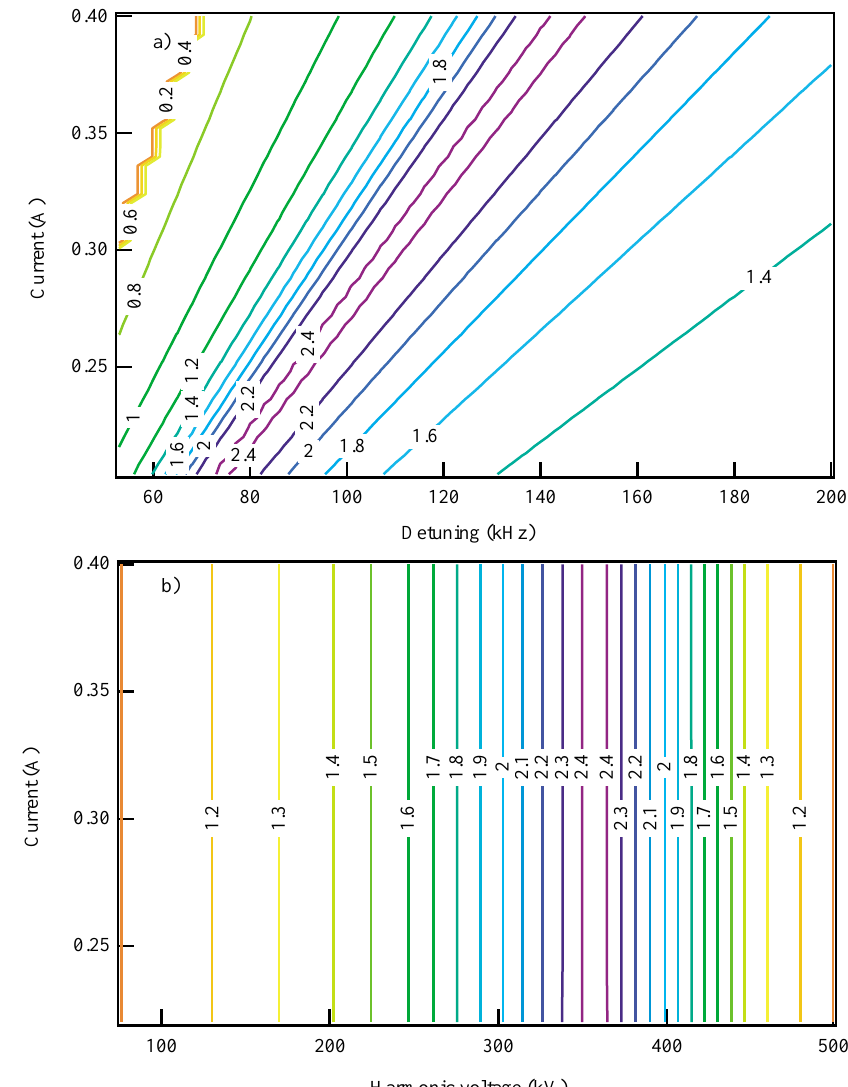
FIG. 8. (Color) Contour plot of the calculated lifetime improvement as a function of beam current and (a) detuning and (b) fixed voltage. The Elettra SC cavity parameters are used for the